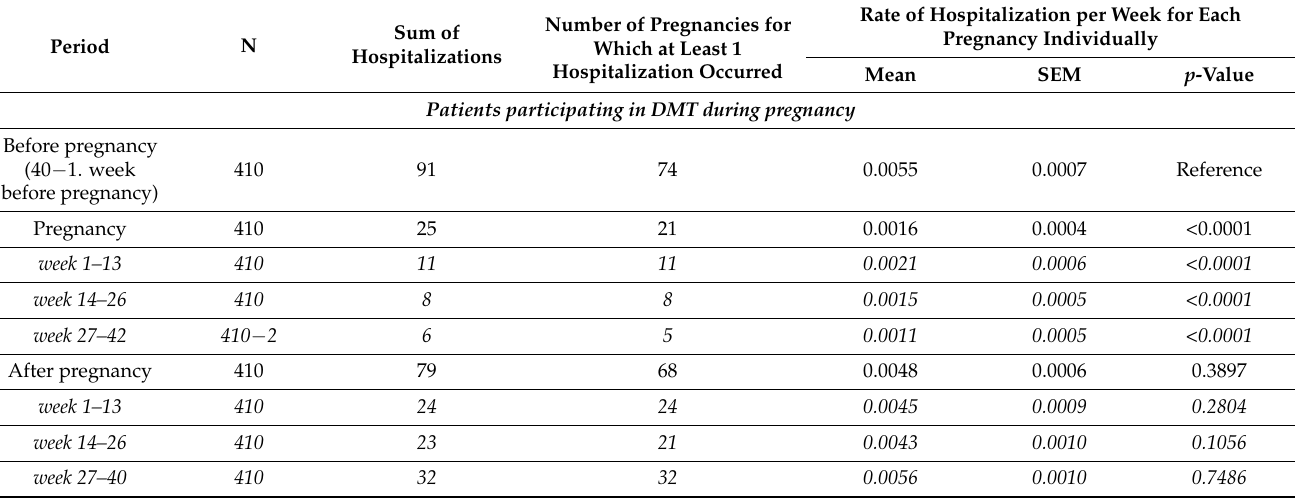
Figure 5. Weekly rate of at least 1-day hospitalizations without reported DMT products among women who participated or not participated in DMT during pregnancy. Rates in each period are compared with the reference period before pregnancy for each group separately. *– p -value < 0.05, ***– p -value < 0.001. Table 4. Number of hospitalizations before, during and after pregnancy with the standard error of the mean. The weekly rate of hospitalizations for each pregnancy during and after pregnancy was compared to the rate before pregnancy using Wilcoxon tests for pairs, separately for groups of patients participating or not participating in DMT during pregnancy.